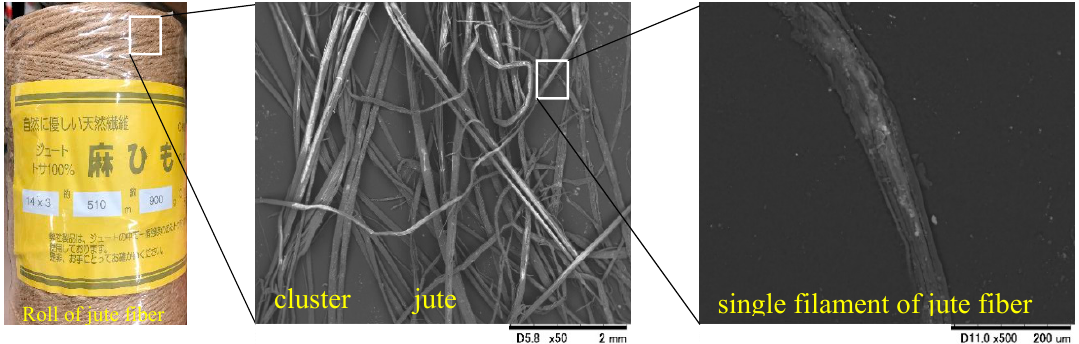
Figure 1. Appearance and microstructure images of jute fibers, obtained using SEM.